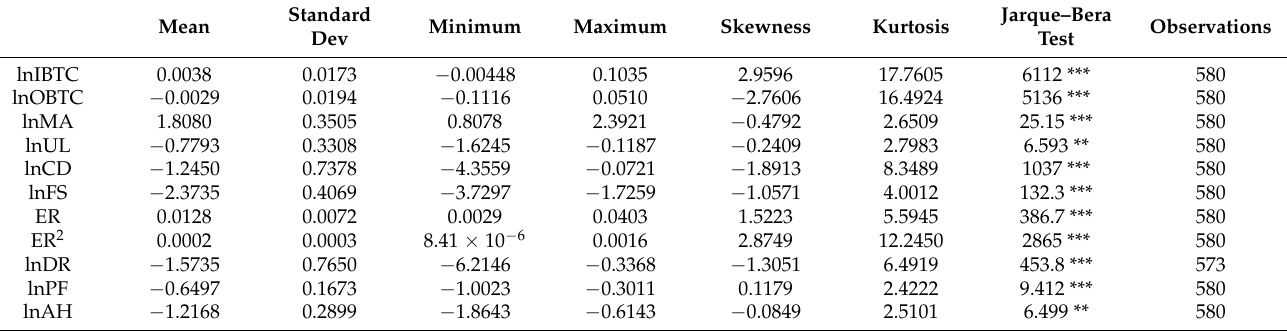
Table 6. Descriptive